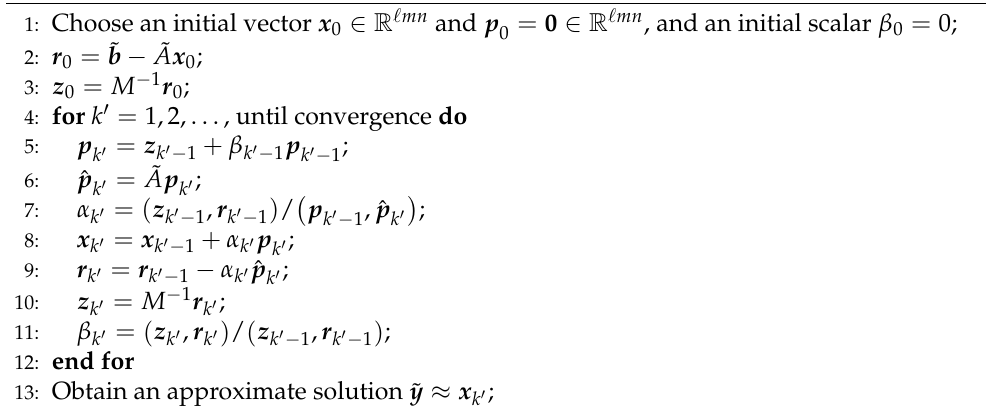
Algorithm 2: PCG method over vector space for ˜ A ˜ y = ˜